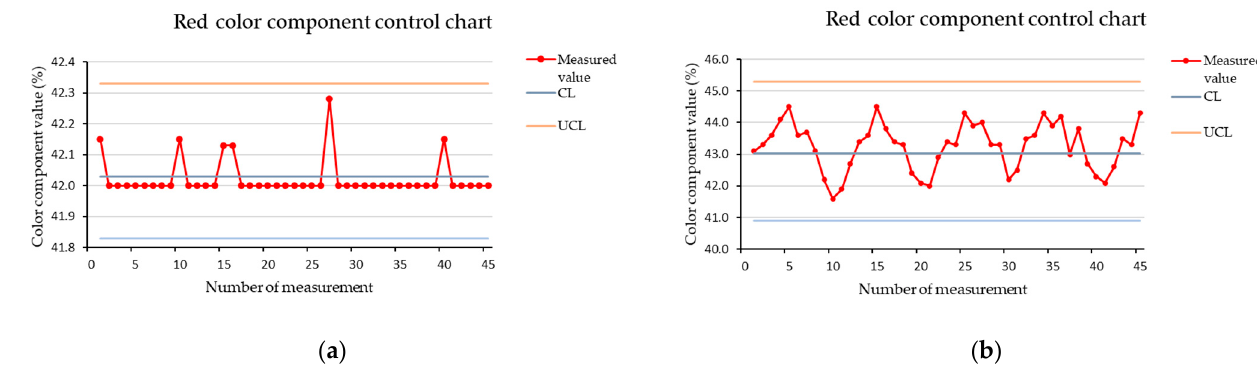
Figure 5. Red color component control chart for a brown cube measured in the dark, at a scanning distance of 15 mm, ( a ) stopped cube; ( b ) cube in motion.